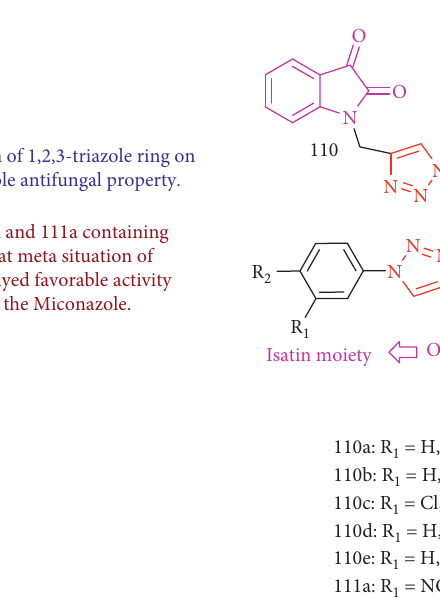
Figure 50: Chemical structure of novel triazole-incorporated isatin derivatives as antifungal agents.